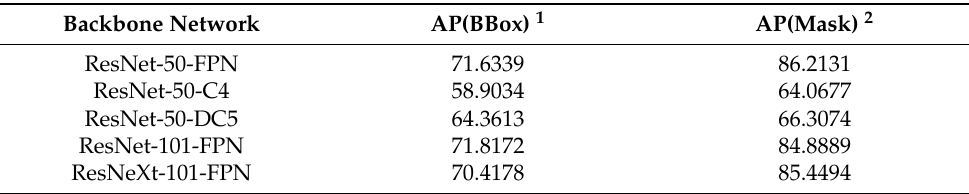
Figure 14. Object segmentation result. Table 6. Average